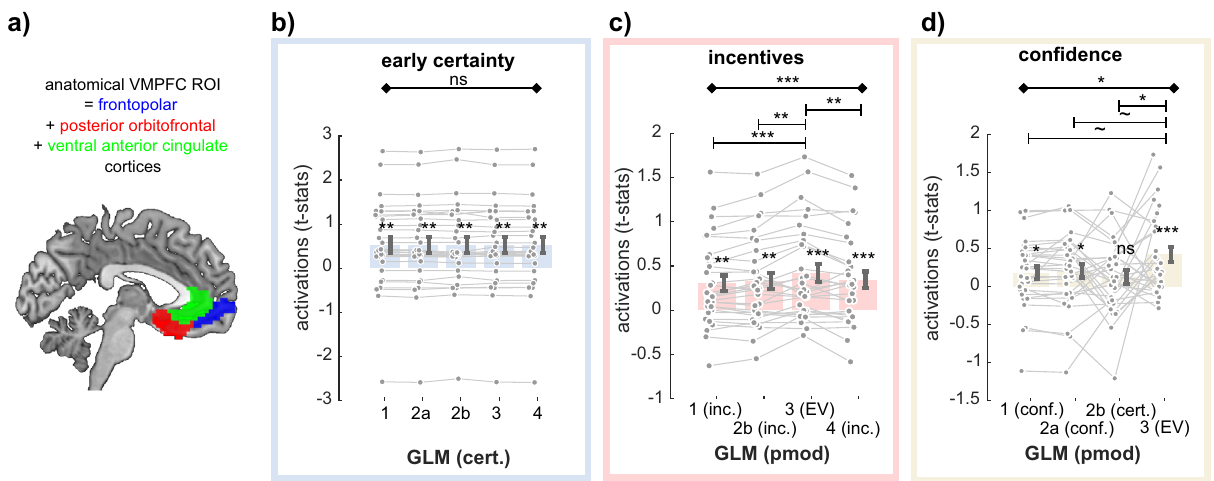
Fig. 4 Activation in ventromedial prefrontal cortex across models. a Anatomical ventromedial prefrontal cortex (VMPFC) region of interest (ROI). b – d Comparison of VMPFC activations to different speci fi cations of early certainty during the choice moment ( b ), incentives during incentive/rating moment ( c ), and con fi dence during incentive/rating moment ( d ), as implemented in the different GLMs. Dots represent individual activations; bar and error bars indicate sample mean ± standard error of the mean. Gray lines highlight within-subject variation across the different speci fi cations. N = 30. Cert early certainty; Inc. incentives; conf. con fi dence; EV expected value. Diamond-ended horizontal bars indicate the results of repeated-measure ANOVAs. Dash-ended horizontal bars indicate the result of post hoc paired t tests. ~ p < 0.10; * p < 0.05; ** p < 0.01; *** p <